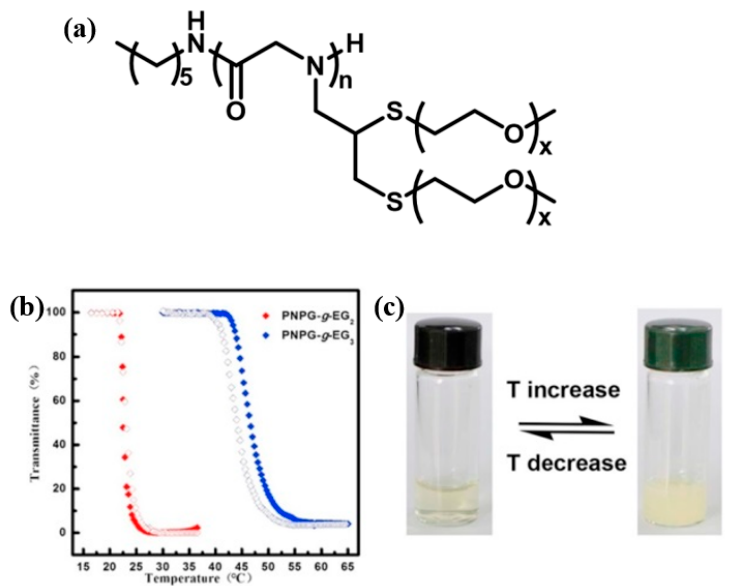
Figure 10. ( a ) Structure of HEX-PNPgG n - g -EG x . ( b ) Plots of transmittance as a function of temperature for aqueous solutions (2 mg/mL) of HEX-PNPgG n - g -EG x . Filled symbol: heating ramp, open symbol: cooling ramp. ( c ) The photographs of HEX-PNPgG n - g -EG x aqueous solution showing reversible phase transition. Reprinted with permission from [49] . Copyright 2018, Elsevier.